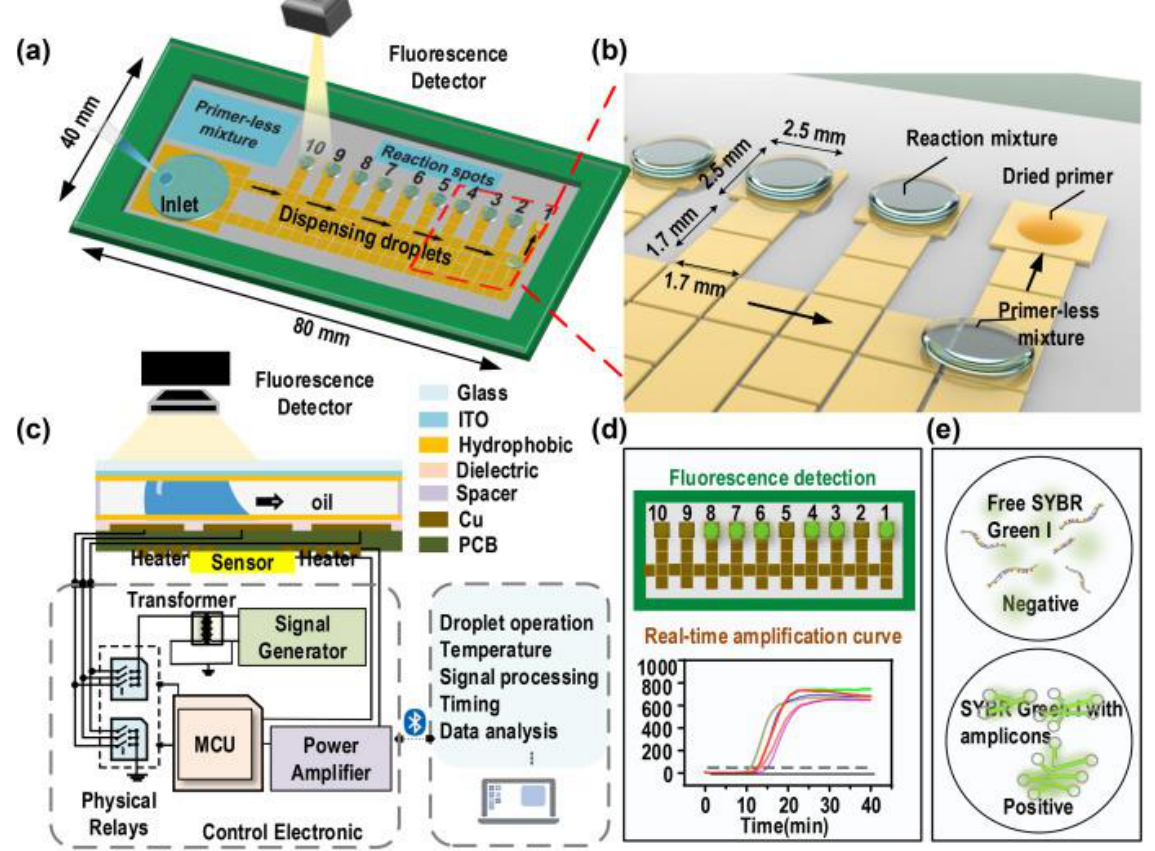
Figure 6. Detection of foodborne pathogens using digital microfluidic chip with loop-mediated isothermal amplification ( a ) schematic of digital microfluidic chip, ( b ) chip with primers (both dried and rehydrated), ( c ) side view of the chip along with representation of control system, and ( d ) results of on-chip loop-mediated isothermal amplification (LAMP) reaction, and ( e ) schematic of LAMP results with dye. Reprinted/adapted with permission from Ref. [122]. 2022, Elsevier.